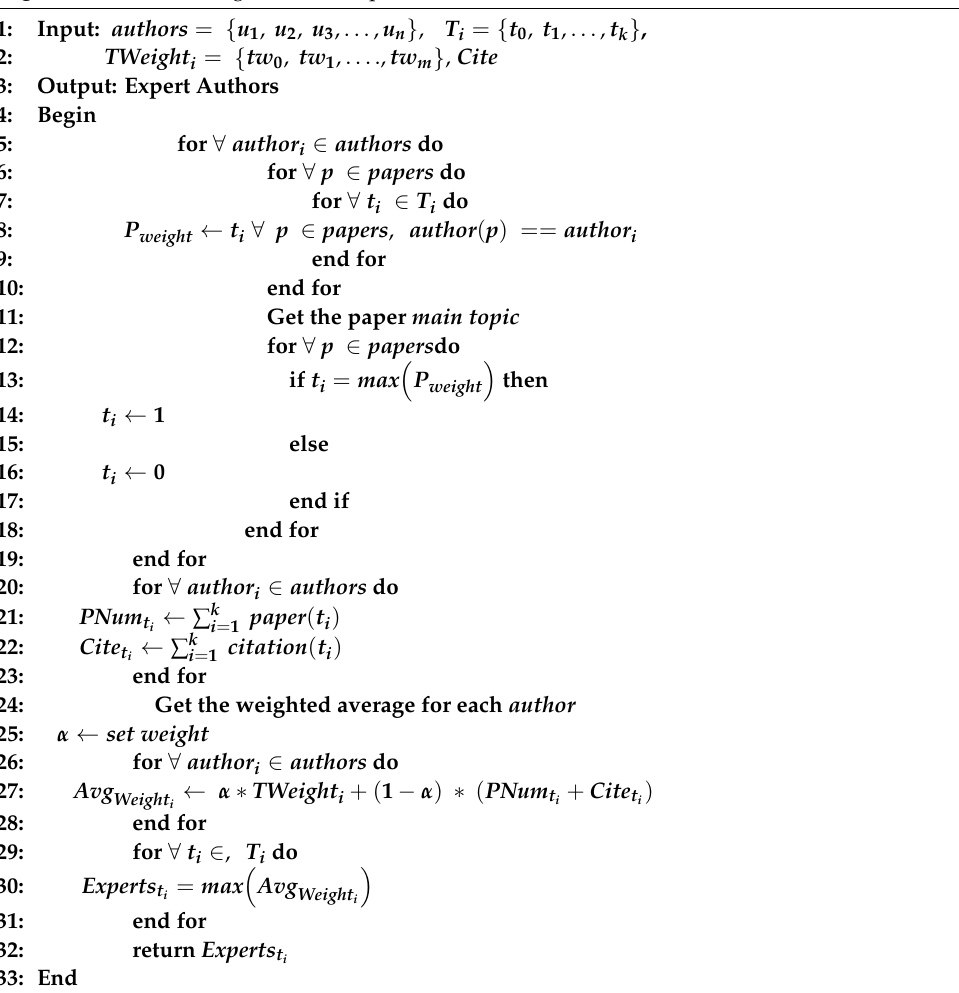
Algorithm A3 Extracting Authors’